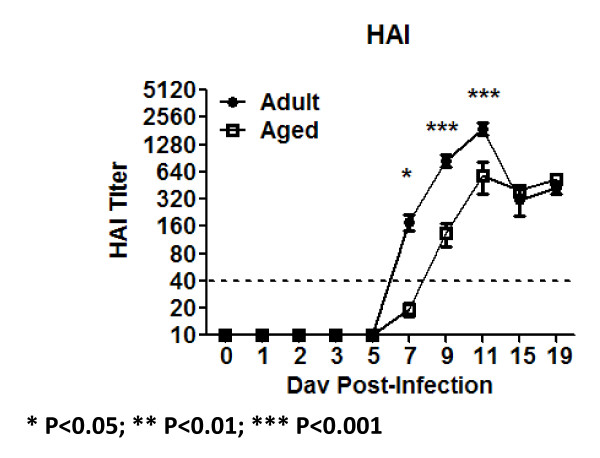
Anti-Influenza Neutralizing Antibodies. Anti-influenza neutralizing antibodies titers were assayed in sera samples by HAI assay. Aged animals (black circles) developed antibodies at neutralizing titer (1:40 -- dotted line) quicker than aged mice (white squares). The arithmetic mean (± SEM) of the sera HAI titer at each time point was plotted. Six mice per time point were assayed, except at days 7 and 15, where 10 mice were assayed. Stars indicate statistical difference between aged and naïve animals. *P < 0.05. **P < 0.01. ***P < 0.001.